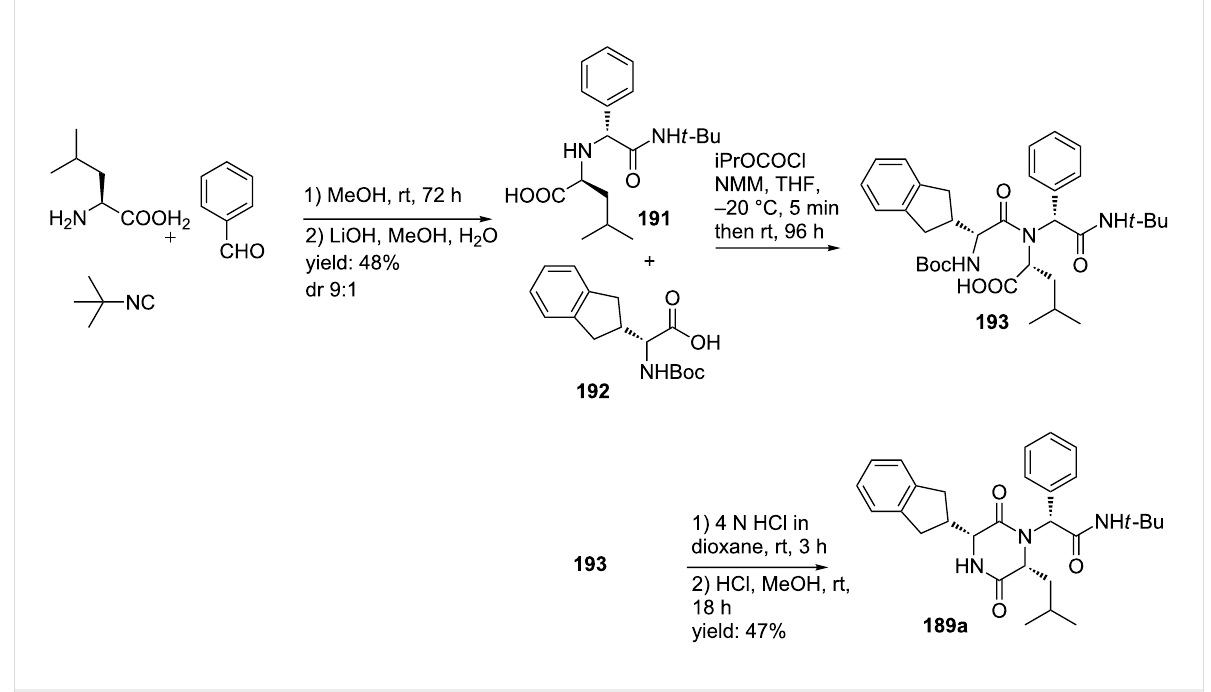
Scheme 58: An improved stereoselective MCR-approach towards the oxytocin inhibitor.